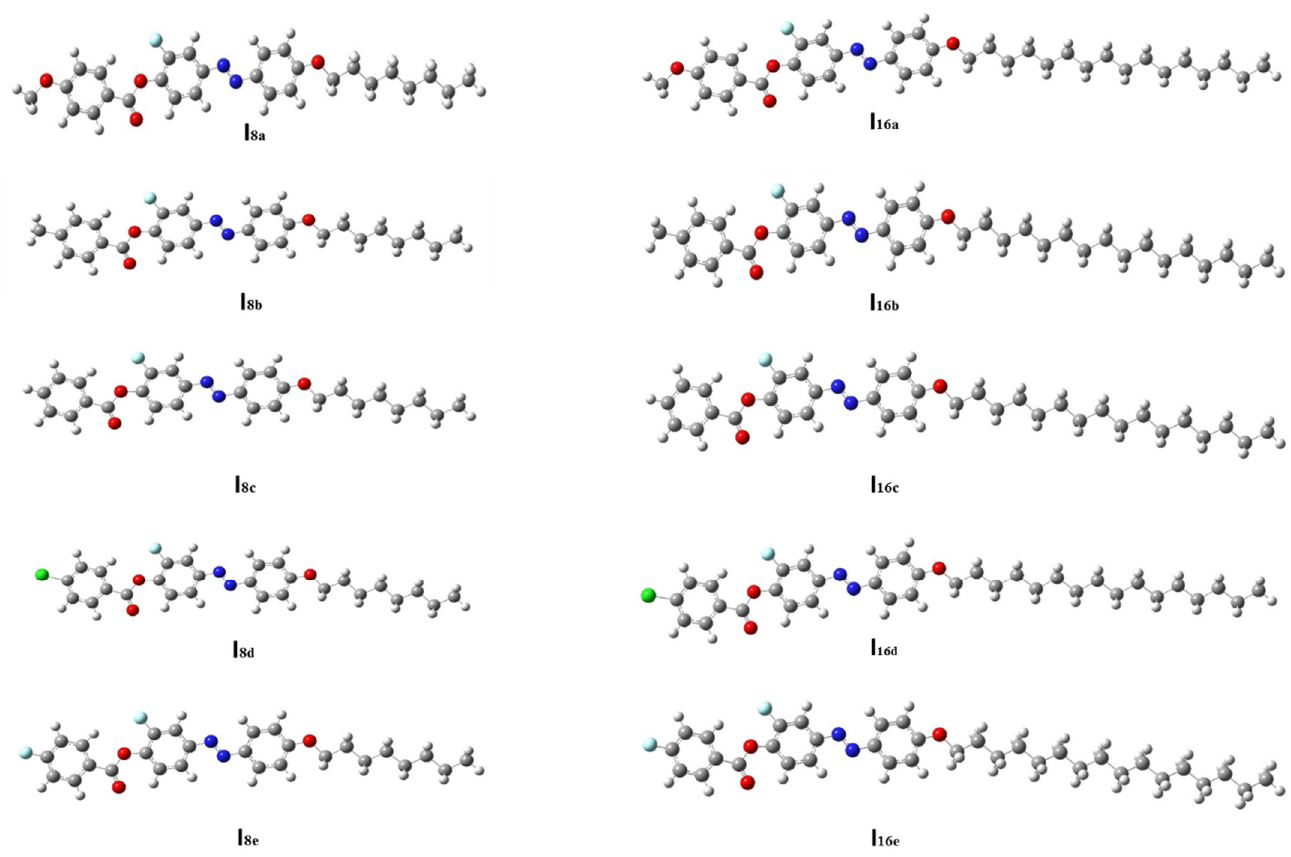
Figure 4. The optimized molecular structures of analogues series In x , predicted at B3LYP/6–311G ** level. Table 2. Estimated thermal parameters for present series, In x .